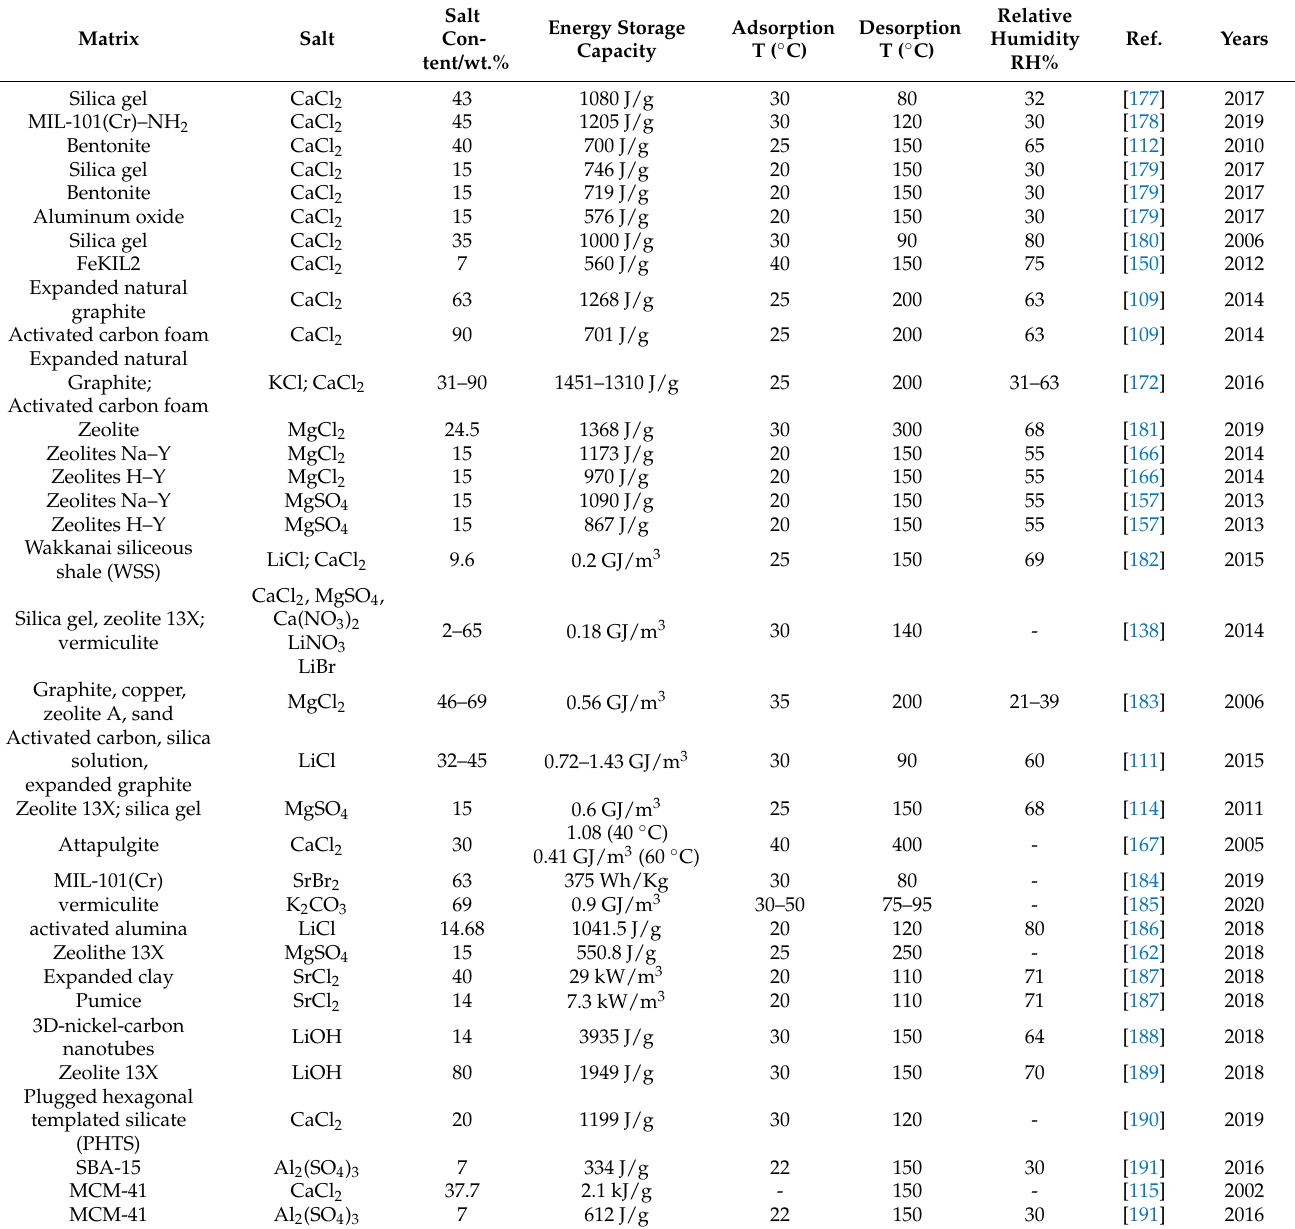
Table 4. List of salt hydrates composites for TCES